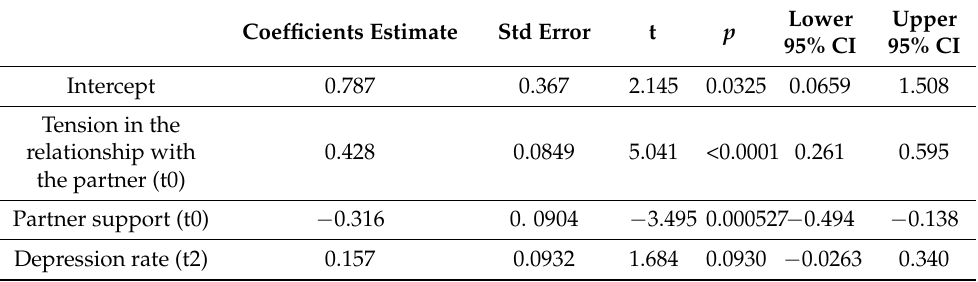
Table 4. Coefficient estimates of the regression model. The total IPV score during the t2 served as the dependent